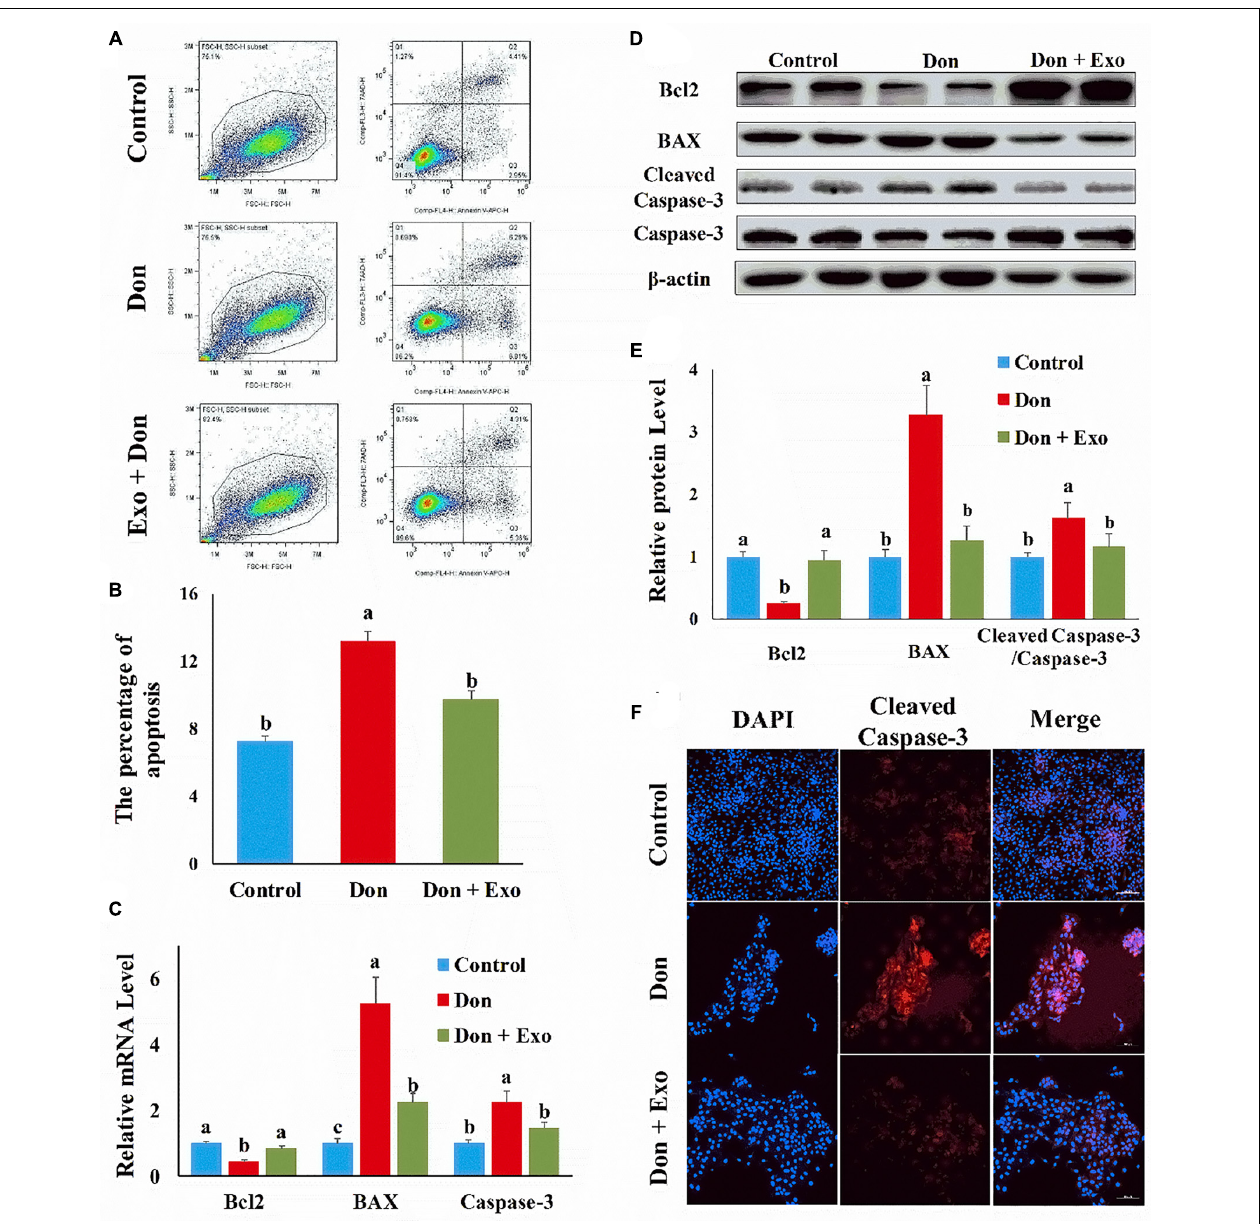
FIGURE 1 | Exosome attenuated deoxynivalenol (Don)-induced intestinal epithelial cell apoptosis. (A) Representative images of apoptosis assay for intestinal epithelial cells by using the apoptosis detection kit. Cells localized in Q4 displayed Annexin V-APC-negative/7AAD-negative viable cells. The cells gated in Q2 and Q3 quadrant displayed Annexin V-APC-positive apoptotic cells. (B) The quantitative result of (A) . (C) qPCR results indicated that exosome attenuated Don-induced intestinal epithelial cell apoptosis. (D) Western blot results showed exosome-attenuated Don-induced intestinal epithelial cell apoptosis. (E) The relative protein levels obtained by Western blot (WB) band gray scanning. (F) Representative images of the caspase-3 immunofluorescent staining for apoptotic intestinal epithelial cells. Cleaved caspase-3: red, a molecular marker of apoptosis; DAPI: blue, cell nucleus; Merge: the apoptotic cells. The results were presented as mean ± SEM of triplicate independent experiments for each group. Bars with different letters indicate they are significantly different ( p < 0.05). In (F) , magnification = × 100; the scale bar on the photomicrographs represents 100 µ m. Don, IPEC-J2 cells were exposed to 1.6 µ g/ml Don for 12 h. Don + Exo, IPEC-J2 cells were incubated with 2 mg/ml exosome for 24 h, then exposed to 1.6 µ g/ml Don for 12 h.